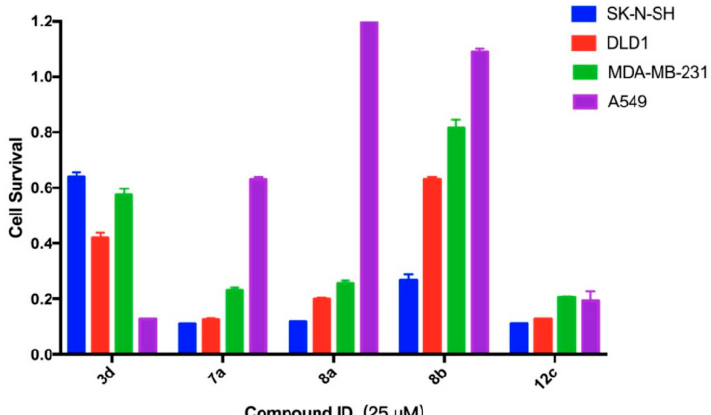
Figure 3. Effects of compounds 3d , 7a , 8a , 8b and 12c on cell viability of four cancer cell lines. Percentage of viable cells (SK-N-SH, DLD1, MDA-MB-231 and A549) after 72 h exposure to the compounds at a concentration of 25 μ M. Each value was calculated from two independent experiments. The competitive inhibitory activity was expressed as an inhibition rate.